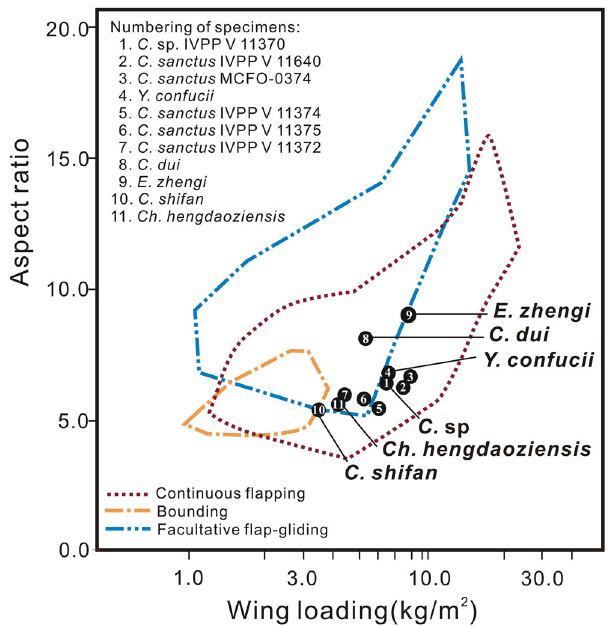
Fig. 9 Positions of estimated confuciusornithid specimens in a morphospace de fi ned by wing loading (WL) and aspect ratio (AR) of extant birds with particular modes of fl ight. Colored lines mark the areas of morphospace occupied by extant birds with particular modes of fl ight. The image of the morphospace was previously published by Serrano et al. 62 , and is used here with permission. Black circles indicate specimens which are holotypes of their respective species, unless only a specimen number is indicated. The specimens are numbered in descending order of estimated body